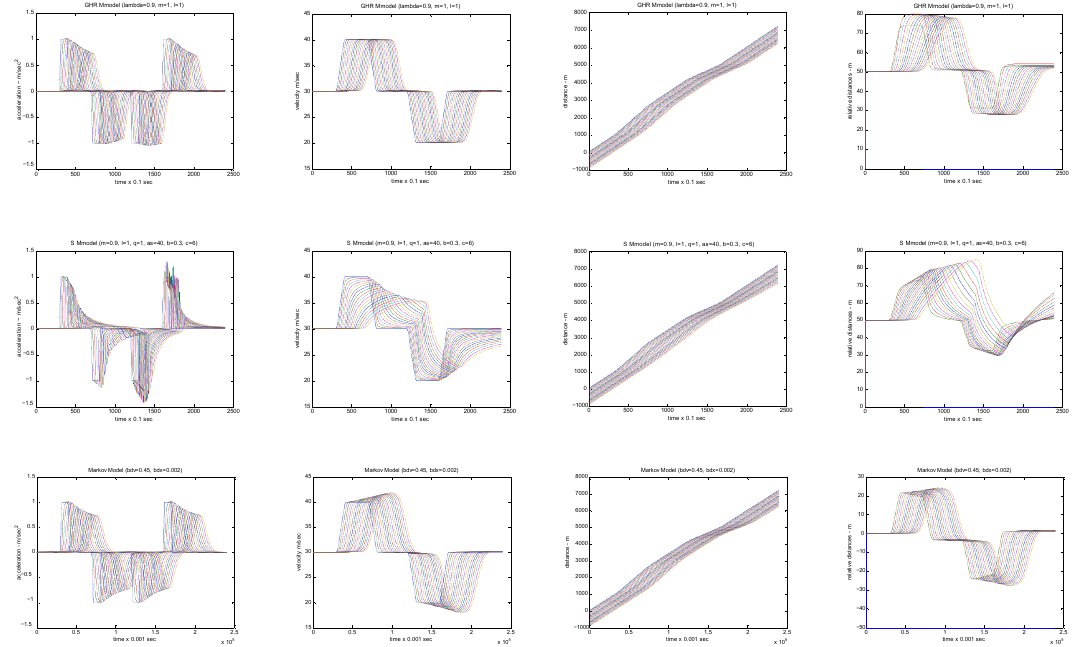
Figure 5. Simulation results obtained with the Gazis–Herman–Rothery (GHR), S-curve, and Markov car-following models (the horizontal axis is time; the vertical axis is value).